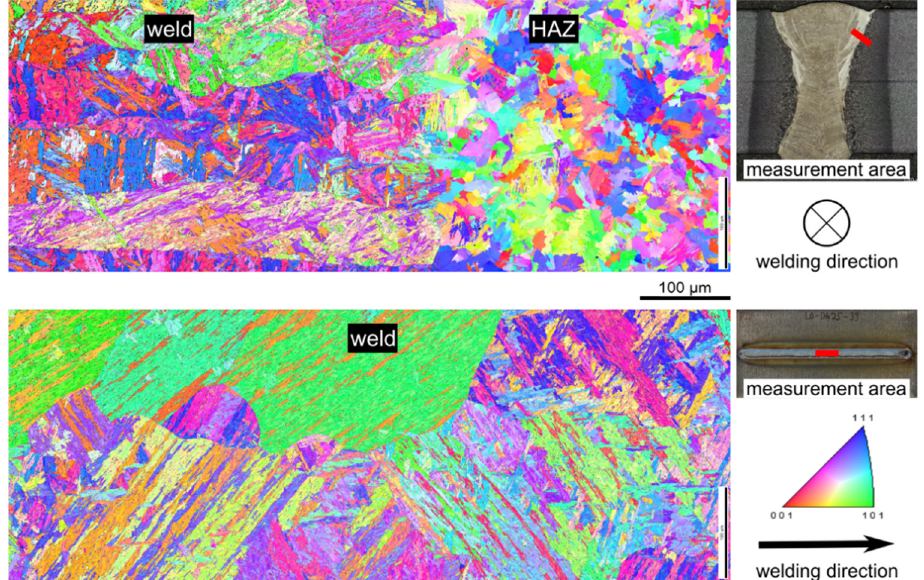
Figure 14. Inverse pole figure maps with respect to the welding direction.